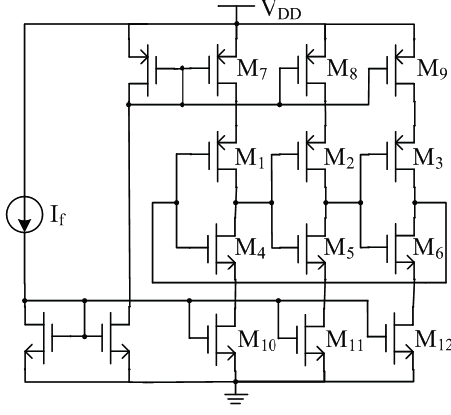
Figure 7. Current-starved ring